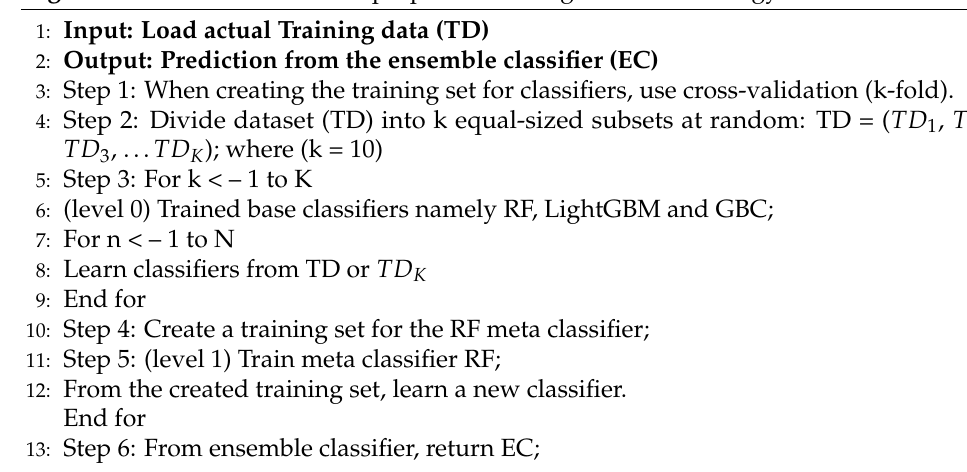
Algorithm 1 Pseudocode of the proposed stacking ensemble